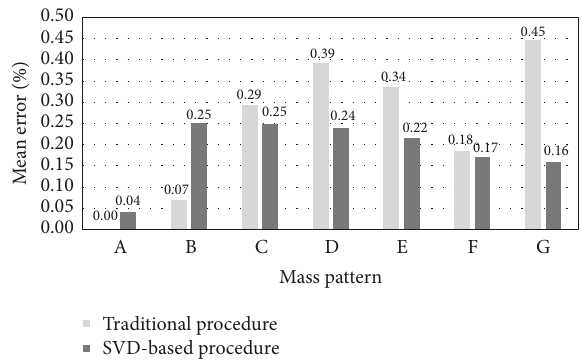
Figure 12: Comparison of average absolute errors on analytical damage indices for the shear-type frame, computed by traditional modal vectors-based procedure and SVD-based procedure with reference to the mass patterns of Table 11 and damage pattern D3 of Table